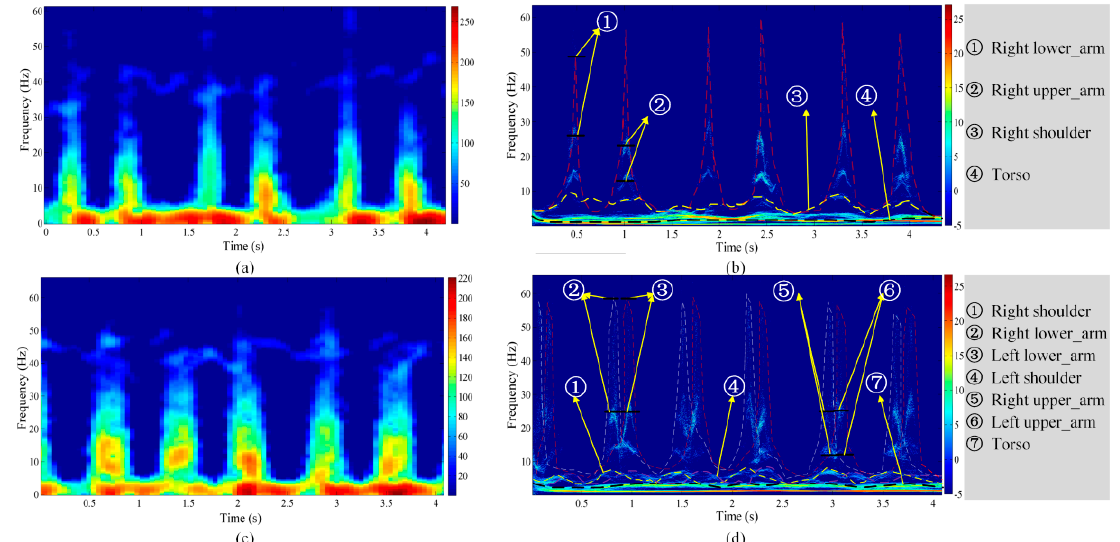
Figure 6. Spectra based on the two methods of the subject swinging one arm or two arms while standing on a spot 3 m behind the wall: ( a ) STFT-based spectrum of the activity of swinging the right arm. ( b ) MHHT-based spectrum of the activity of swinging the right arm. ( c ) STFT-based spectrum of the activity of swinging both arms. ( d ) MHHT-based spectrum of the activity of swinging both arms